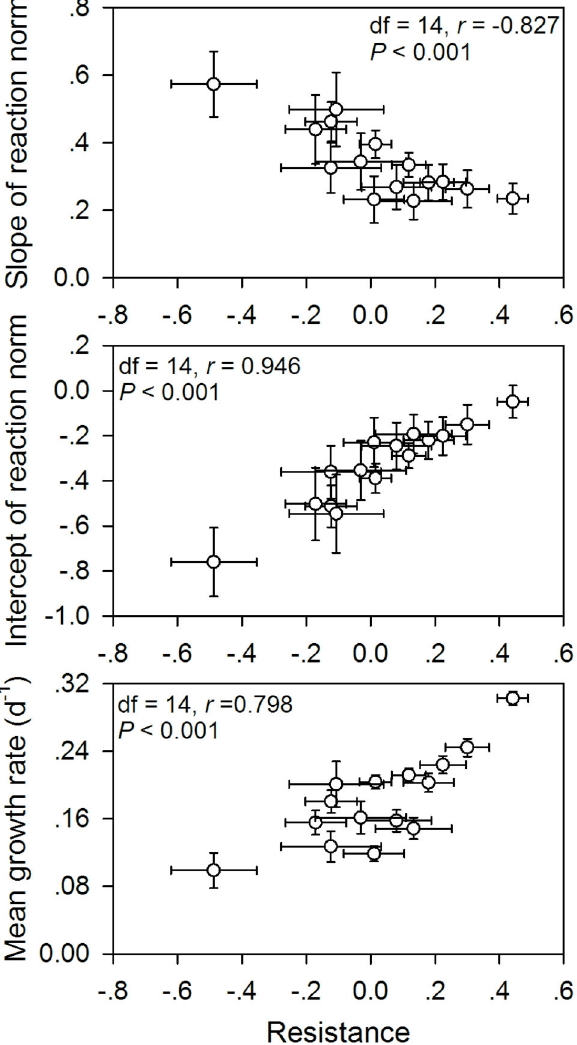
Figure 4. Correlations between the resistances to toxic Microcystis aeruginosa in Bosmina longirostris with three traits of reaction norms of phenotypic plasticity over two diets. Each data point represents one of the 15 sympatric